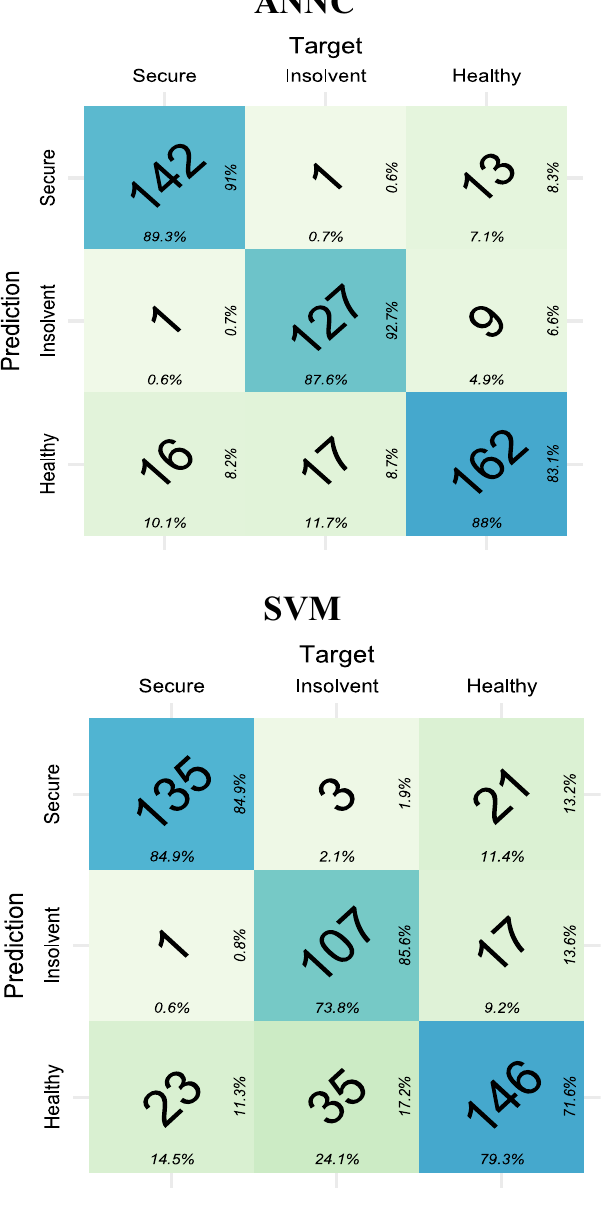
Figure 3. Confusion matrix